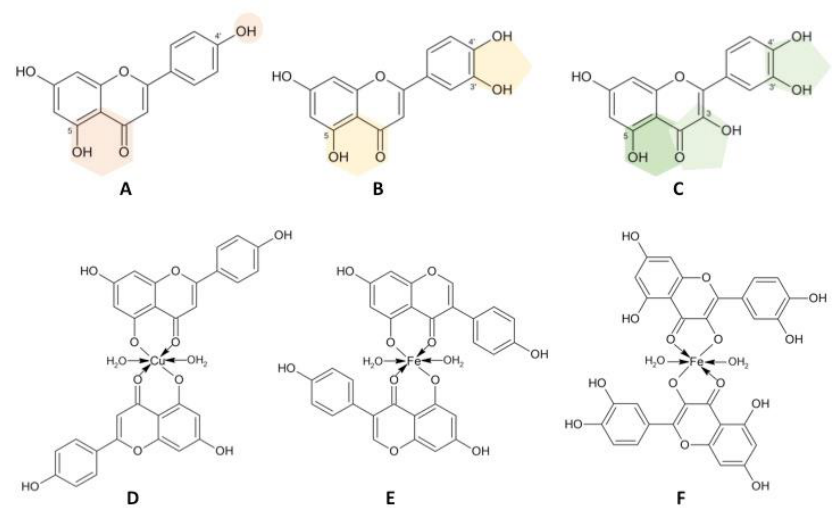
Figure 4. Metal-chelating properties of flavonoids.